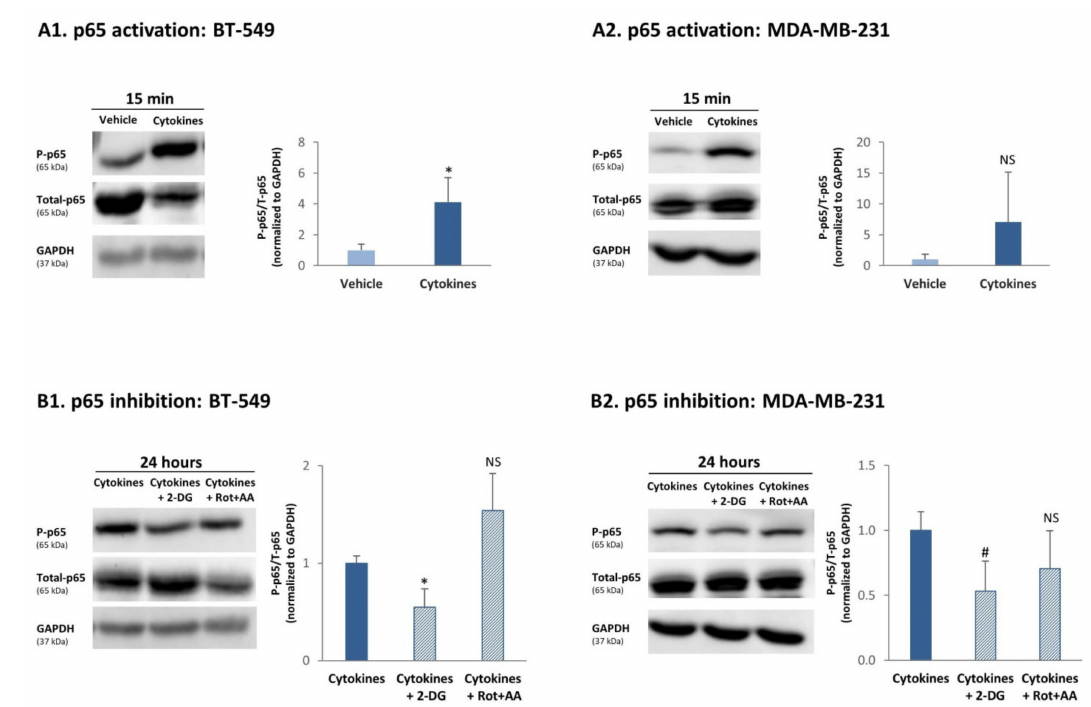
Figure 9. Continuous TNF α + IL-1 β stimulation induces a glycolysis-dependent process of p65 activation in TNBC cells. ( A ) p65 activation. BT-549 and MDA-MB-231 cells were continuously stimulated by TNF α + IL-1 β , or treated by vehicle control (as described in Figure 1). After being continuously treated by cytokines/vehicle, BT-549 cells ( A1 ) and MDA-MB-231 cells ( A2 ) were washed and treated by TNF α + IL-1 β /vehicle for 15 min. The levels of p65 phosphorylation were determined in Western blot analyses as P-p65/Total-p65; each of the two signals was normalized to GAPDH (loading control) beforehand. The results of a representative experiment of n ≥ 3 are presented in the blots. The averaged results of n ≥ 3 are presented in the graphs ( ± SD), where the values of vehicle-treated cells in the different experiments were given the value of 1. * p < 0.05. NS, Not significant. The arbitrary phosphorylation values obtained in the three MDA-MB-231 experiments demonstrated in Table S7A indicate that a consistent upregulation of p65 phosphorylation was obtained following cytokine stimulation. ( B ) The roles of glycolysis and OXPHOS in inducing p65 activation. BT-549 and MDA-MB- 231 TNBC cells were continuously stimulated by TNF α + IL-1 β (as described in Figure 1). Following continuous cytokine stimulation, BT-549 cells ( B1 ) and MDA-MB-231 cells ( B2 ) were washed and stimulated by TNF α + IL-1 β for 24 h (in order to enable the inhibitors to act) in the presence of a glycolysis inhibitor (2-DG) and OXPHOS inhibitors (Rot+AA), or their solubilizer (as described in the materials and methods section). The levels of p65 phosphorylation were determined in Western blot analyses as P-p65/Total-p65; each of the two signals was normalized to GAPDH (loading control) beforehand. The results of a representative experiment of n ≥ 3 are presented in the blots. The averaged results of n ≥ 3 are presented in the graphs ( ± SD), where the values of cytokine-treated cells—without inhibitors—in the different experiments were averaged and were given the value of 1. * p < 0.05, # p = 0.0505, NS = not significant. The arbitrary phosphorylation values obtained in the three MDA-MB-231 experiments demonstrated in Table S7B indicate that a consistent downregulation of p65 phosphorylation was obtained following 2-DG